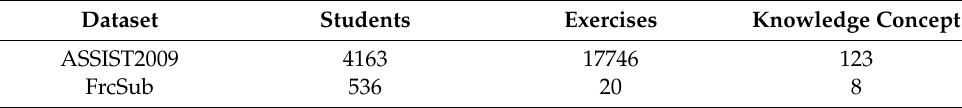
Table 1. Information about the